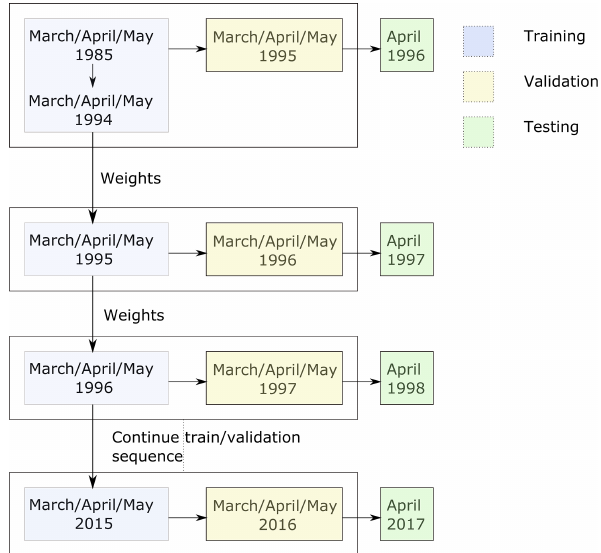
Figure 3. Training, validation, and test protocol used for both the Basic and Augmented